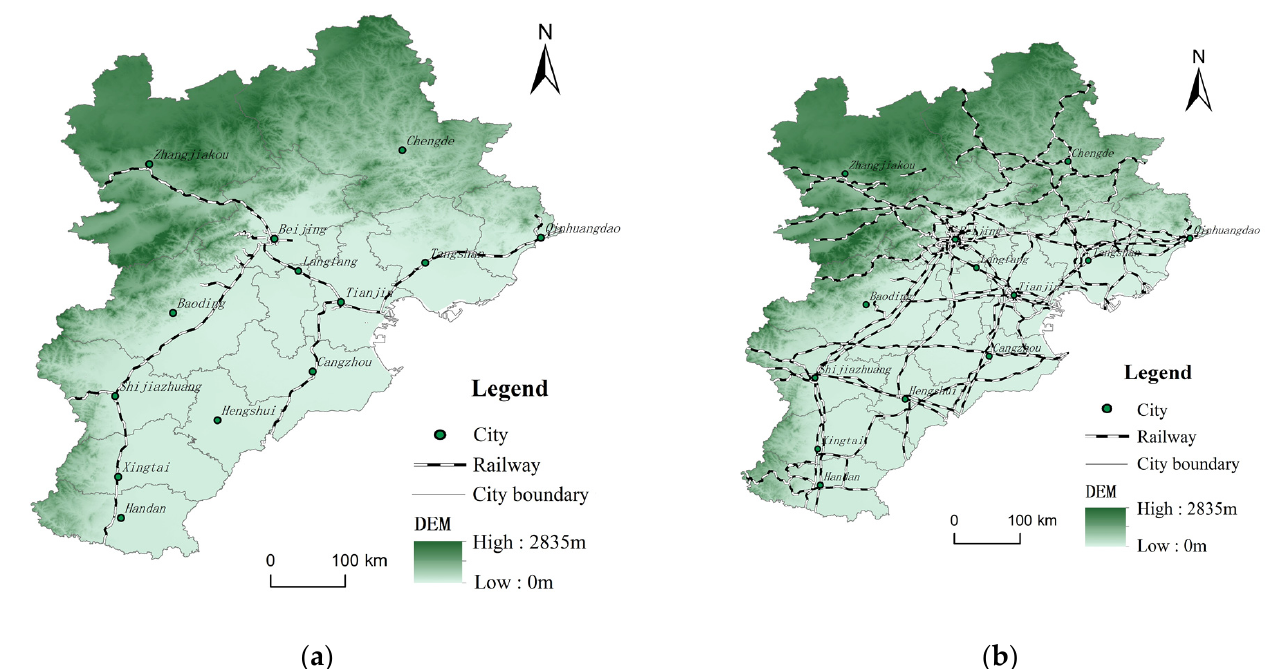
Figure 9. Railways in BTH: ( a ) 1934; ( b )